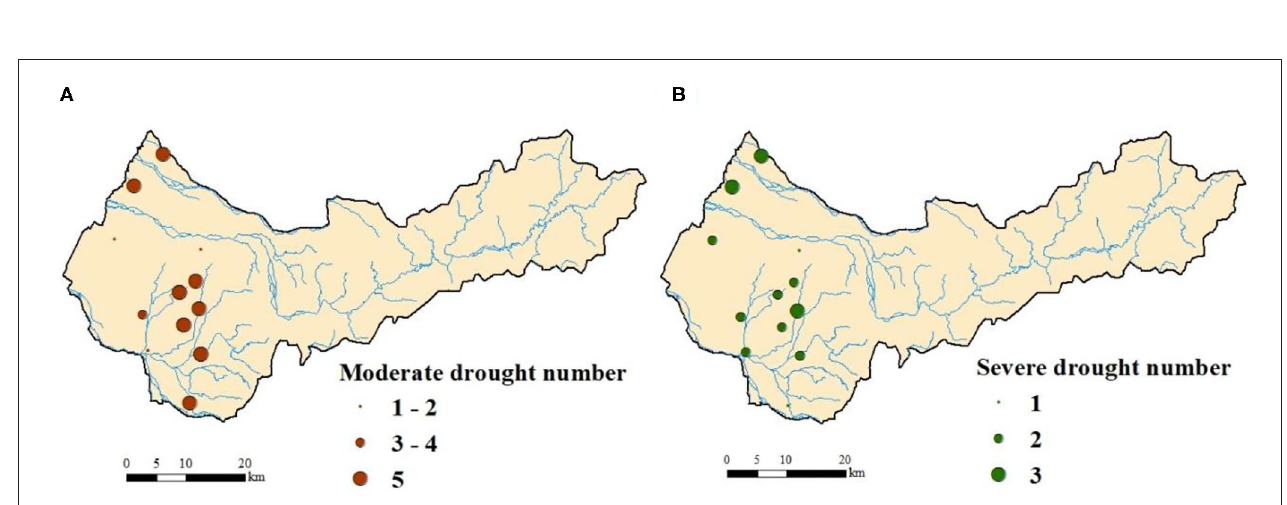
FIGURE 6 | Occurrence frequency of (A) moderate groundwater drought and (B) severe groundwater drought.